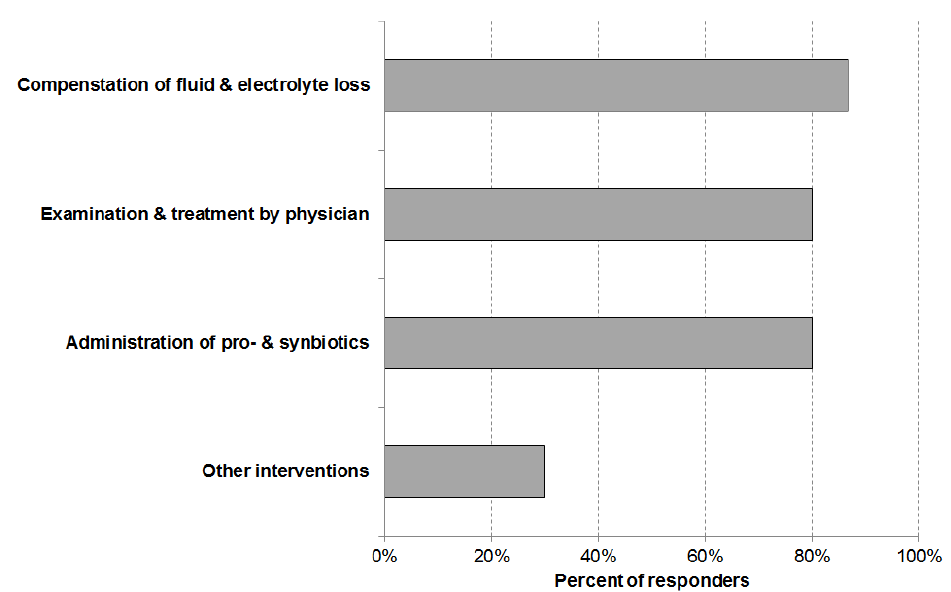
Figure 4. Interventions employed for the management of diarrhea cases in nursing facilities (total number of answers n = 59).